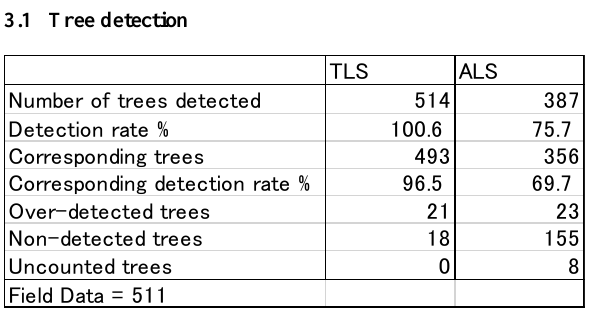
Table 1. Tree detection rates obtained by terrestrial laser scanning (TLS) and airborne laser scanning (ALS)